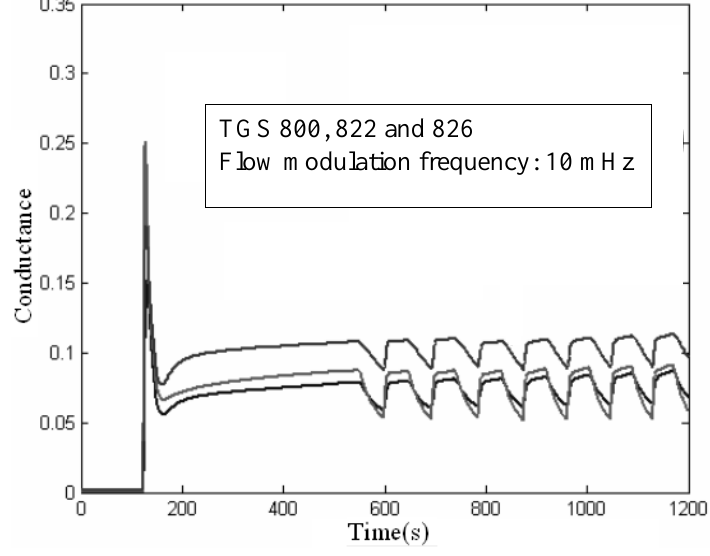
Figure 2. Dynamic response of three sensors. The flow modulation is applied from 550 s onwards.